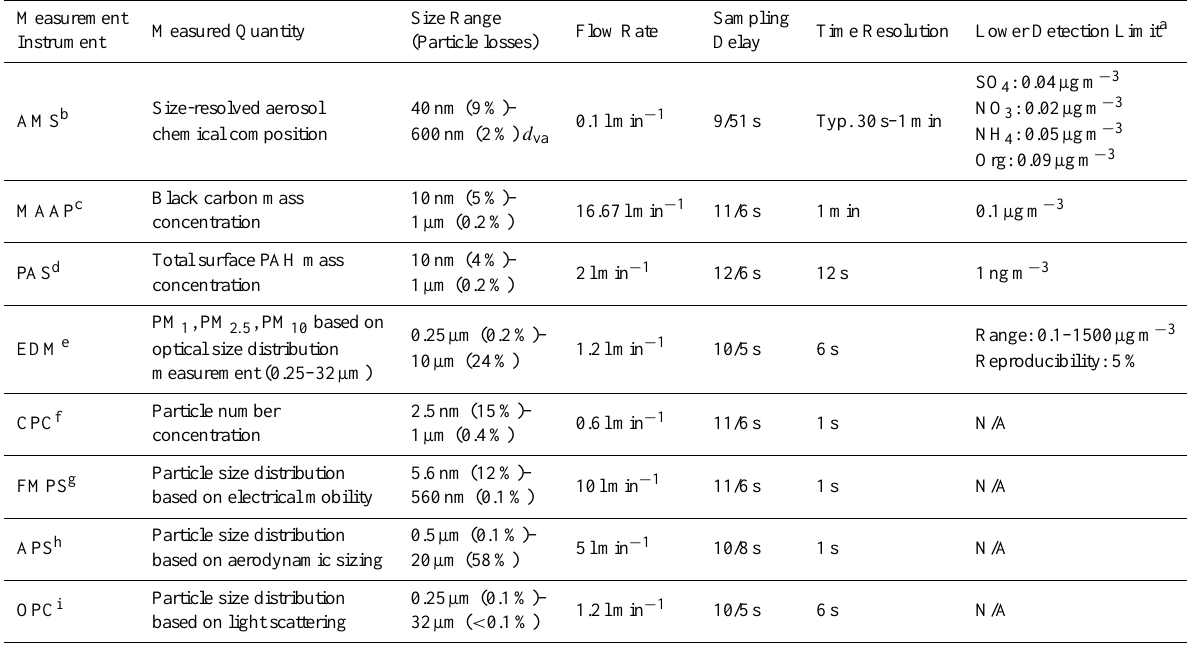
Table 1. Summary of aerosol measurement instruments in MoLa. The losses in the inlet line are provided for the smallest and largest measured particle diameter of the instrument for the roof inlet. The sampling delay (upper front & roof inlet) is the aerosol residence time in the inlet